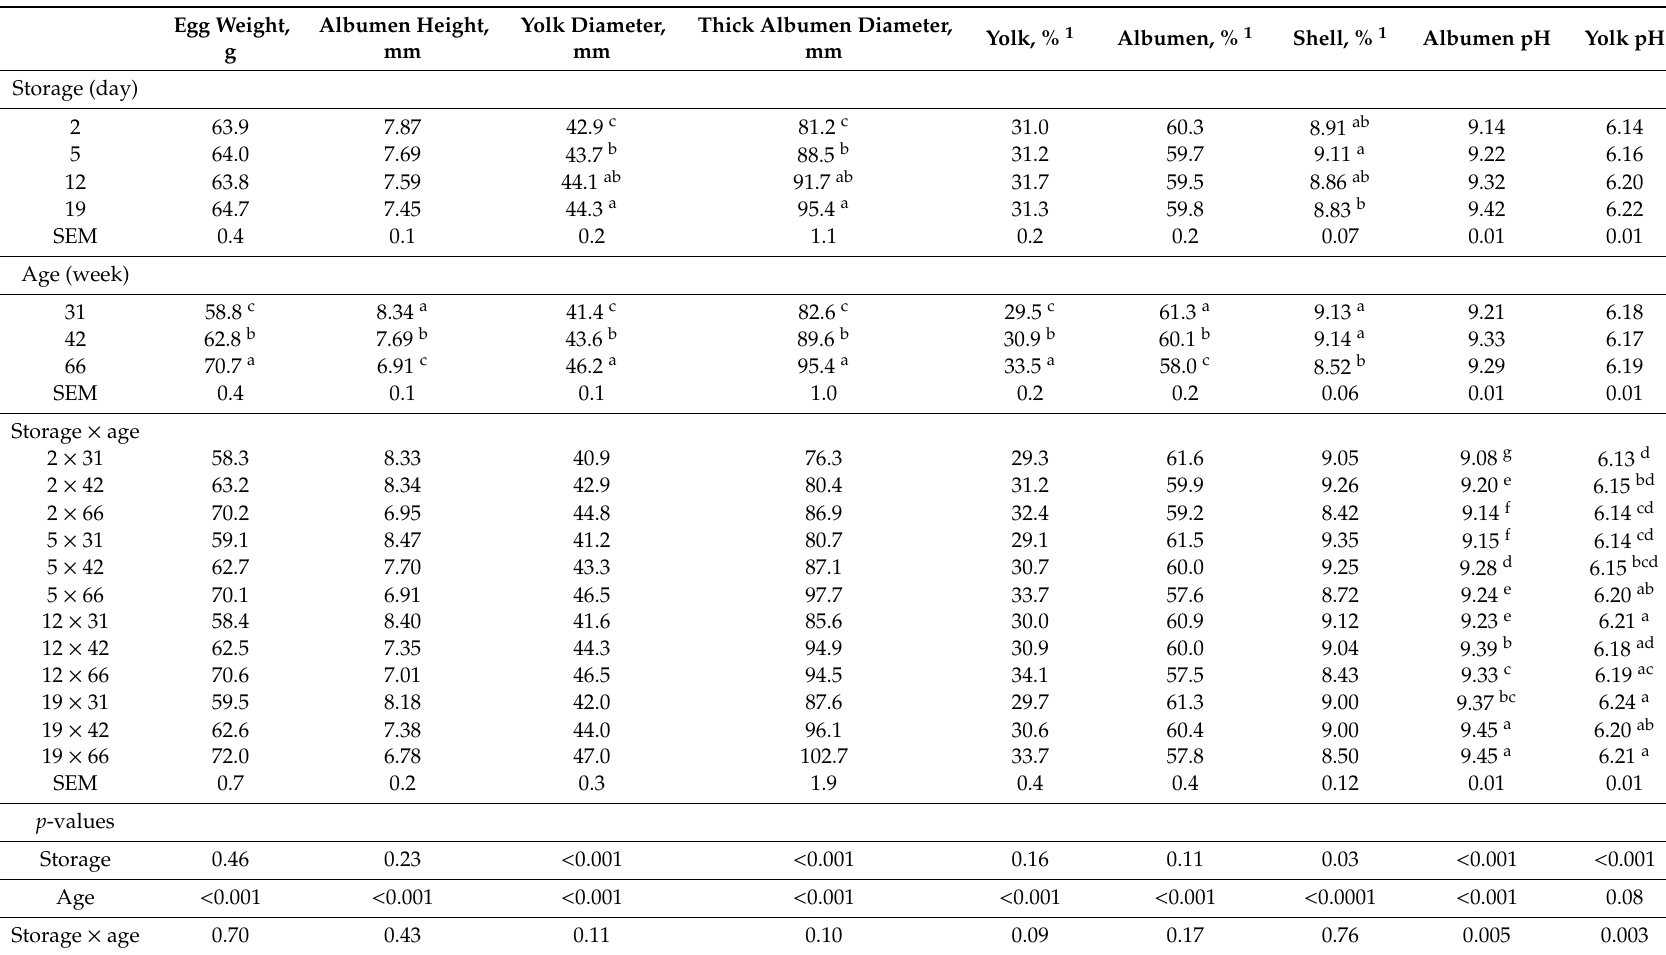
Table 1. E ff ects of egg storage duration and broiler breeder age and their interaction on egg characteristics at the start of incubation (LSMeans ± SEM). Egg Weight, Albumen Height, Yolk Diameter, g mm